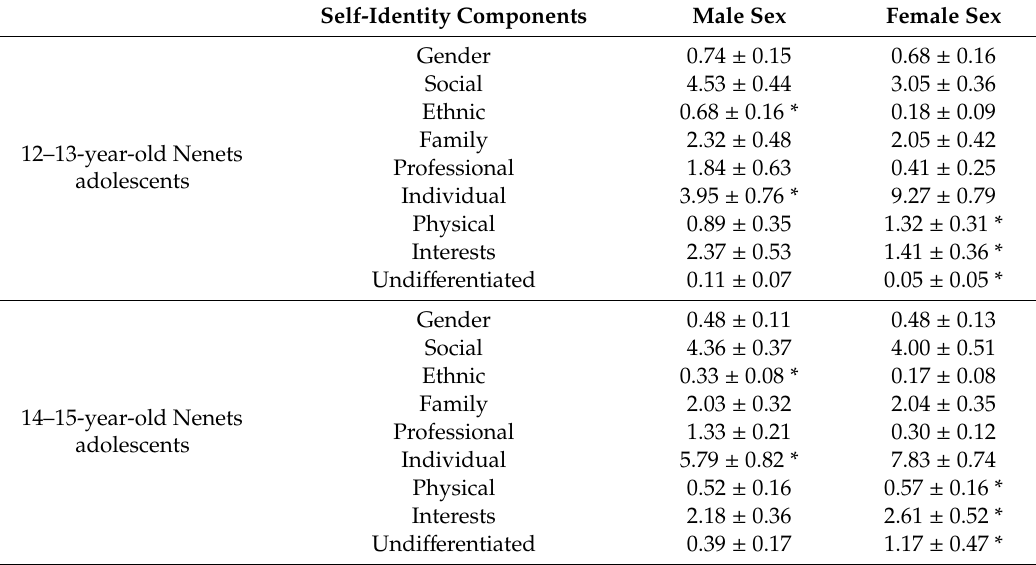
Table 2. Self-identity dynamics among Nenets adolescents when they transition from the age of 12–13 to that of